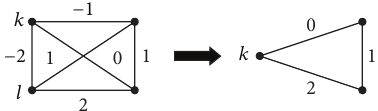
Figure 1: Merging step of the agglomerative